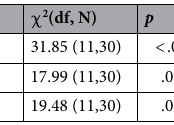
Table 2. Chi-square test parameters by participant using the modified weight